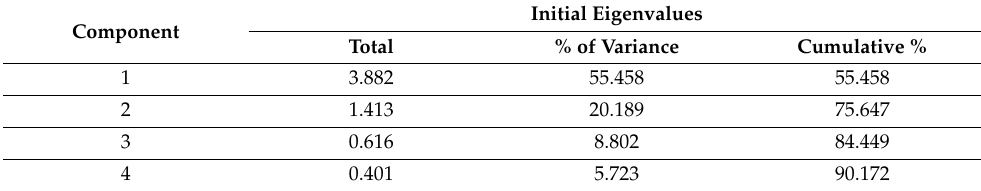
Table 1. Total variance explained of PCA results.